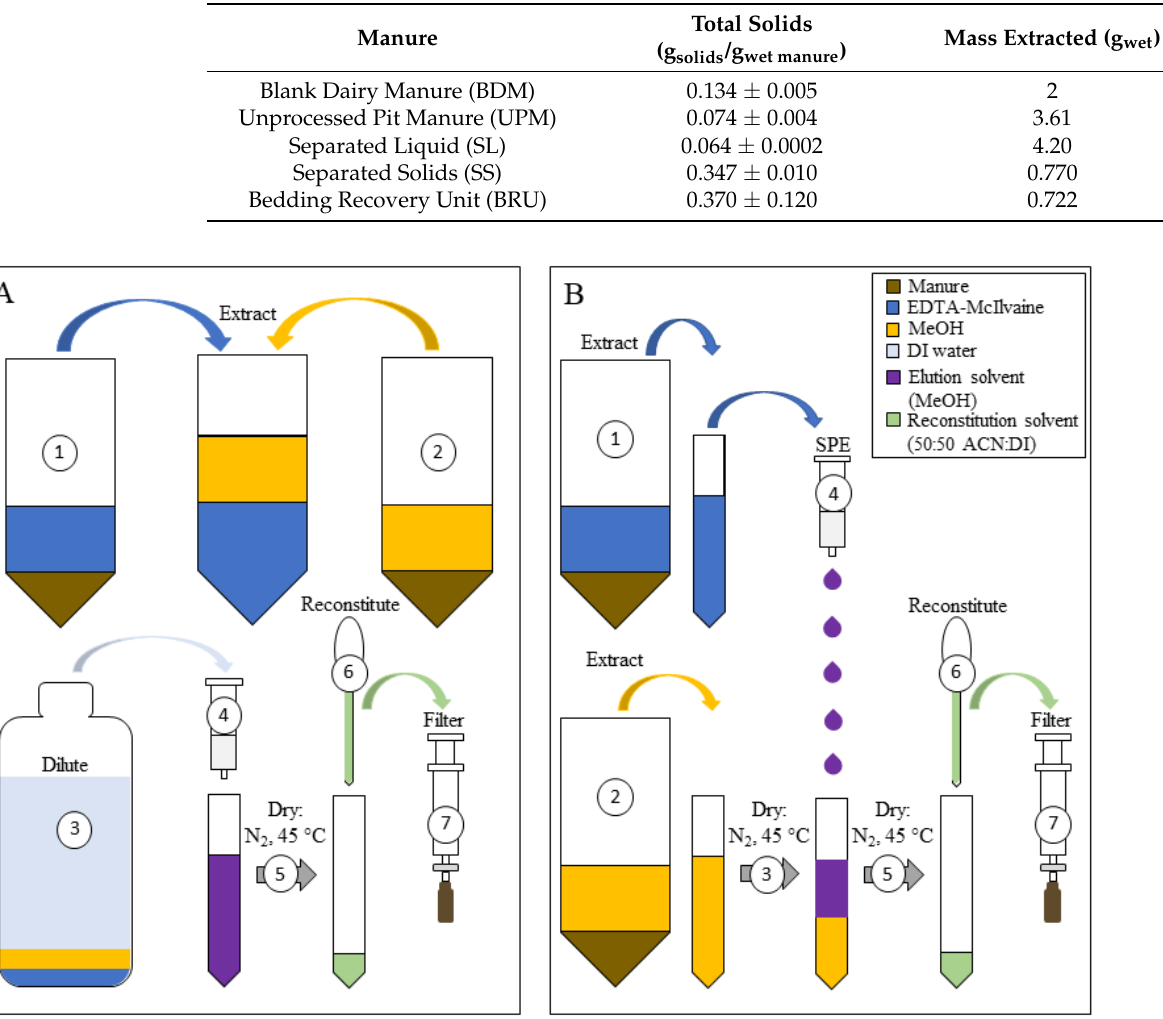
Figure 4. EDTA-McIlvaine and MeOH extracts based on methods in Section 3.6.3 were combined using two methods: ( A ) the two extract fractions were mixed, then diluted to 500 mL with DI water prior to cleanup using solid phase extraction (SPE), and ( B ) the EDTA-McIlvaine fraction was cleaned up using SPE and then eluted into the MeOH fraction. Circled numbers refer to sequence of steps in each method.